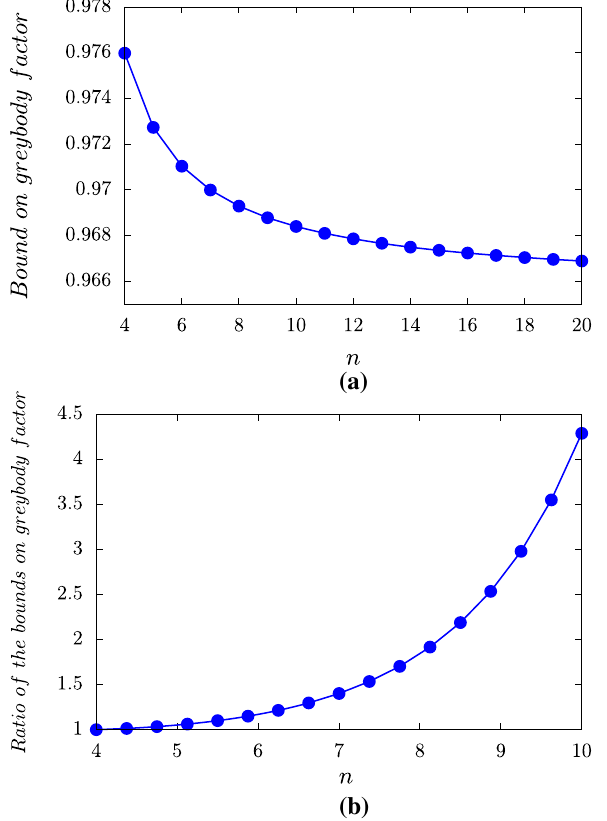
Fig. 3 a Here we plotthe bound on thegreybody factor, corresponding to a brane-localized scalar field, with respect to different spacetime dimension n for l = 1, r H = 1. b The plot of the ratio of the bounds on the greybody factor, corresponding to the brane to bulk scalar field, with respect to varying dimension n for l = 1, r H = 1. For both of the cases the frequency ω = 8 is chosen conveniently and the particular assumption on h is h = ω